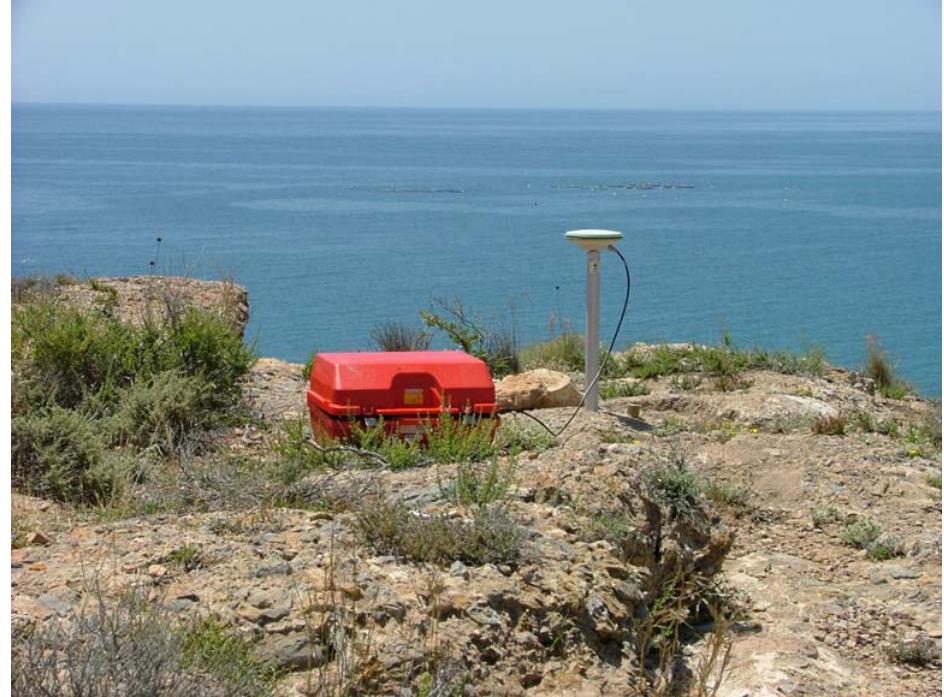
Figure 8. GPS site anchored to solid